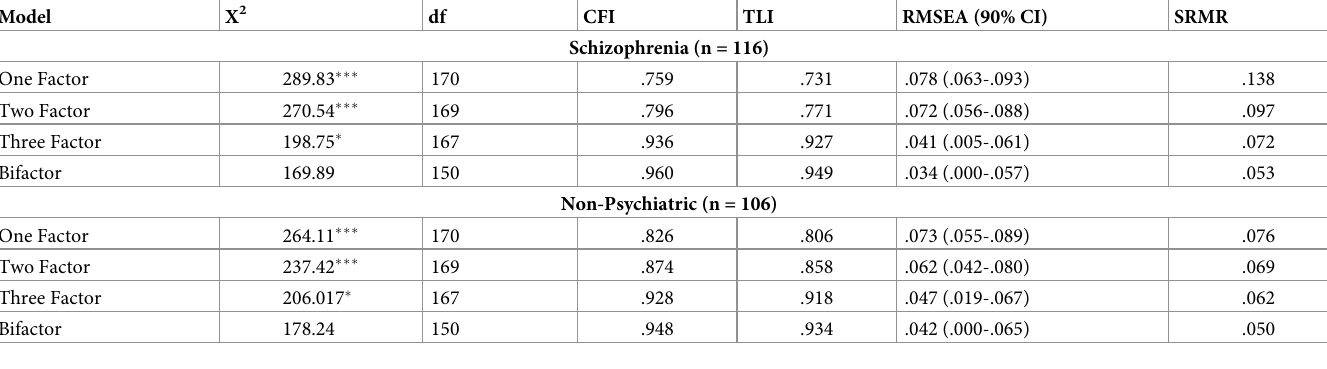
Table 3. Goodness-of-fit indices for factor models of the UCLA Loneliness Scale in schizophrenia and non-psychiatric comparison (NC) groups. Model